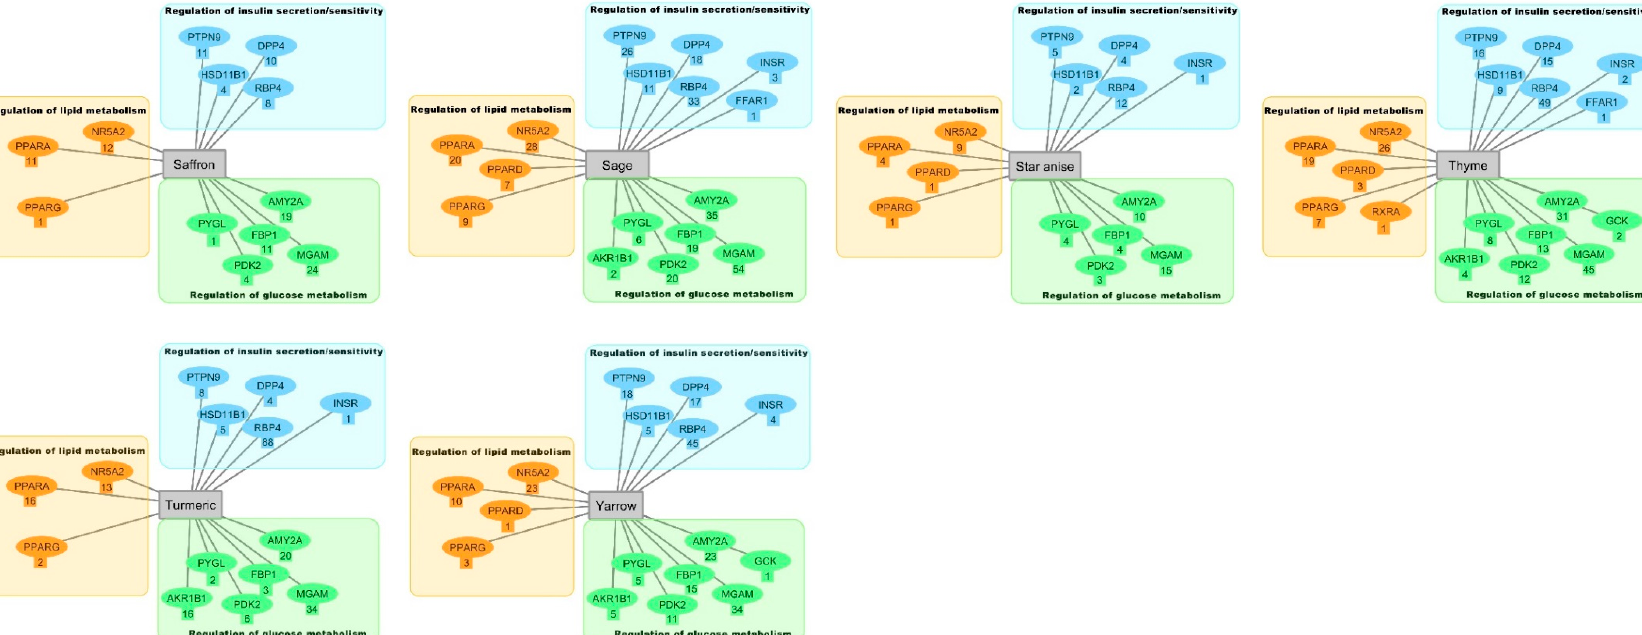
Figure 1. Protein-compound target networks identified for each herb and spice. The number below each protein target denotes the number of potential bioactive compounds identified.